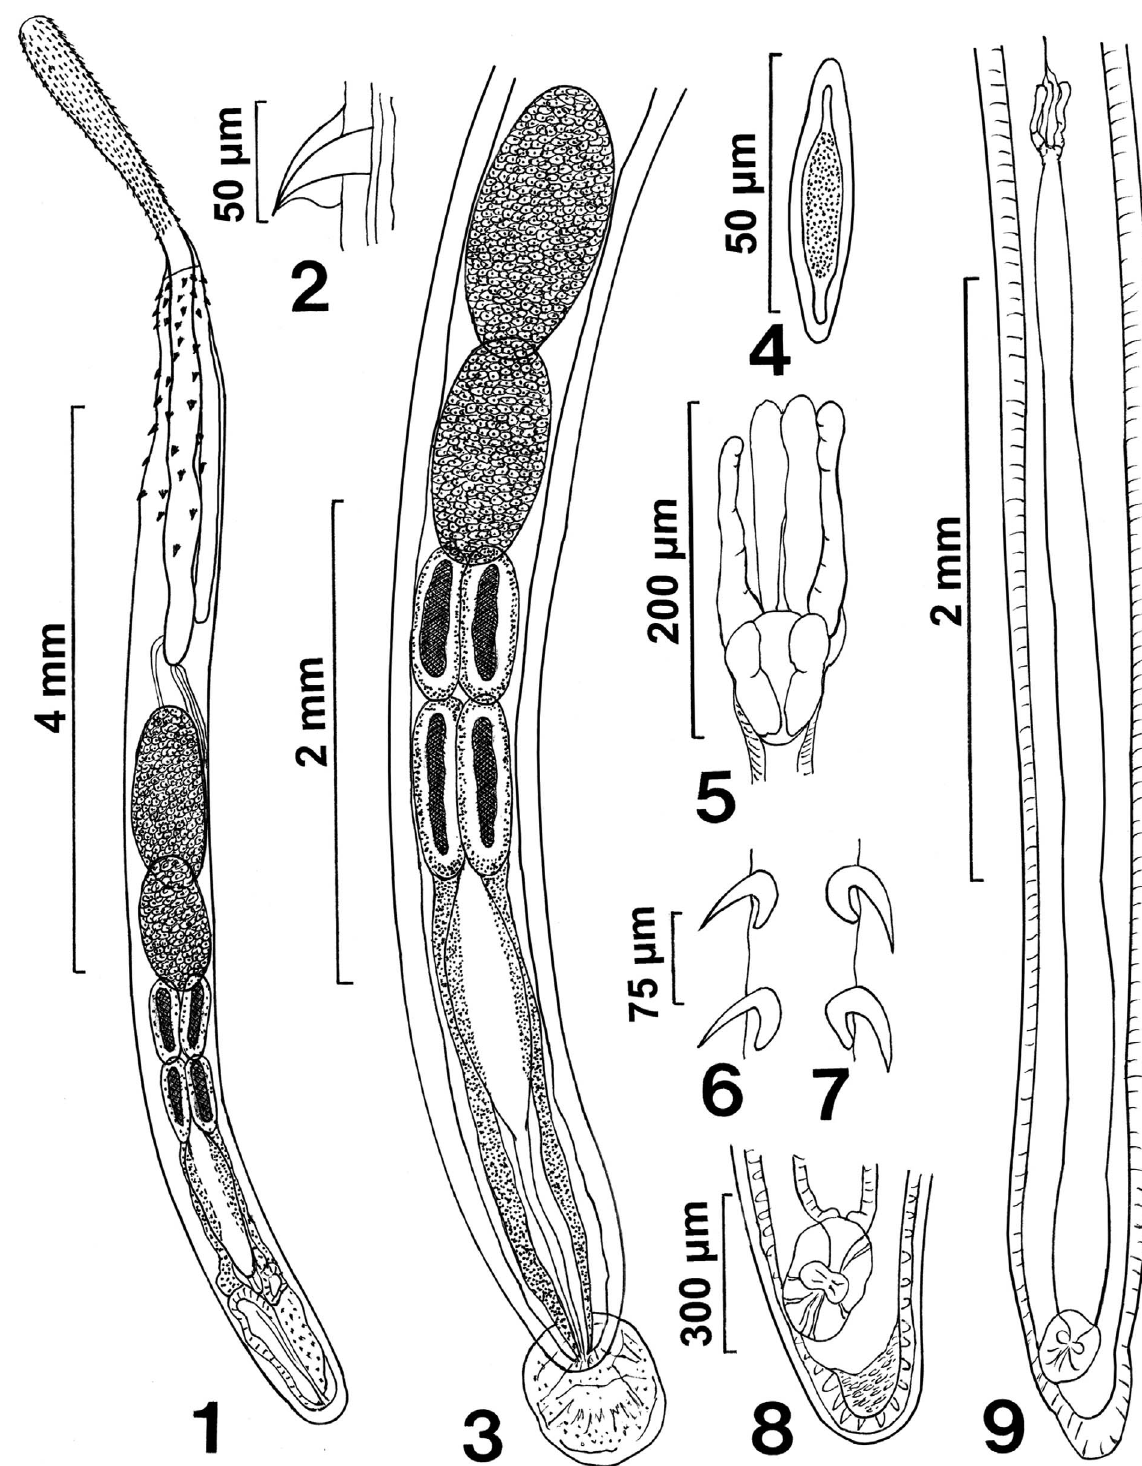
Figures 1 – 9. Line drawings of whole mounted specimens of Rhadinorhynchus laterospinosus from Auxis rochei and Auxis thazard in the Paci fi c Ocean off Vietnam. (1) A paratype male showing the anteriorly enlarged proboscis, the distribution of trunk spines within the range of the long receptacle, and the posterior distribution of the reproductive system. (2) A posterior ventral trunk spine of a female specimen. (3) Detailed male reproductive system. Note the large tubular giant nuclei of the cement glands and the posterior extension of the cement gland ducts surrounding Saefftigen ’ s pouch anteriorly. (4) A ripe egg. (5) Detail of the uterine bell of the female specimen shown in Figure 9. Note the inner paired rod-like structures. (6, 7) Dorsal (Fig. 6) and ventral (Fig. 7) hooks at the mid proboscis of a female specimen. Note differences in the thickness, length, and curvature of dorsal vs. ventral hooks. (8) Detail of the vagina from Figure 9. Note the inner muscular plug lining of the posterior tip of the trunk. (9) A complete female reproductive system characterized by the long and wide